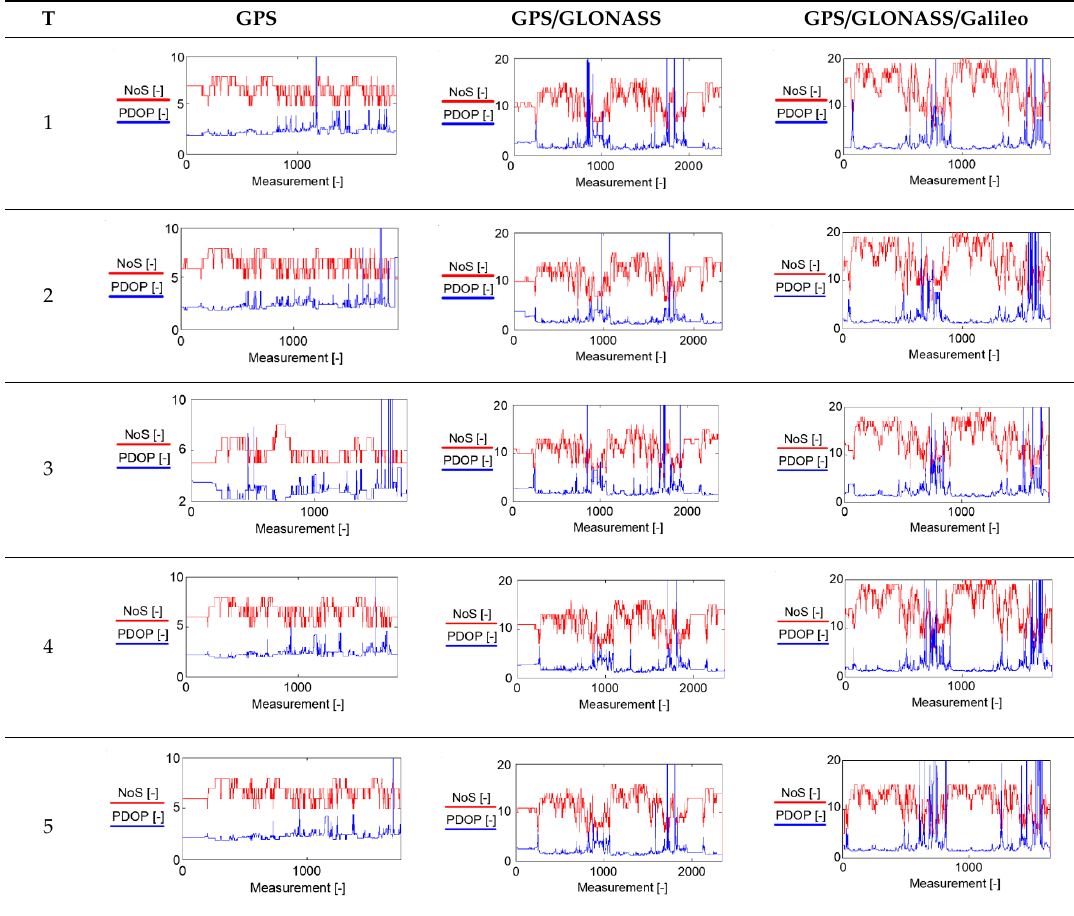
Table 8. The NoS used and PDOP values recorded by five receivers of the T producer for the three GNSS solutions, GPS, GPS/GLONASS and GPS/GLONASS/Galileo.